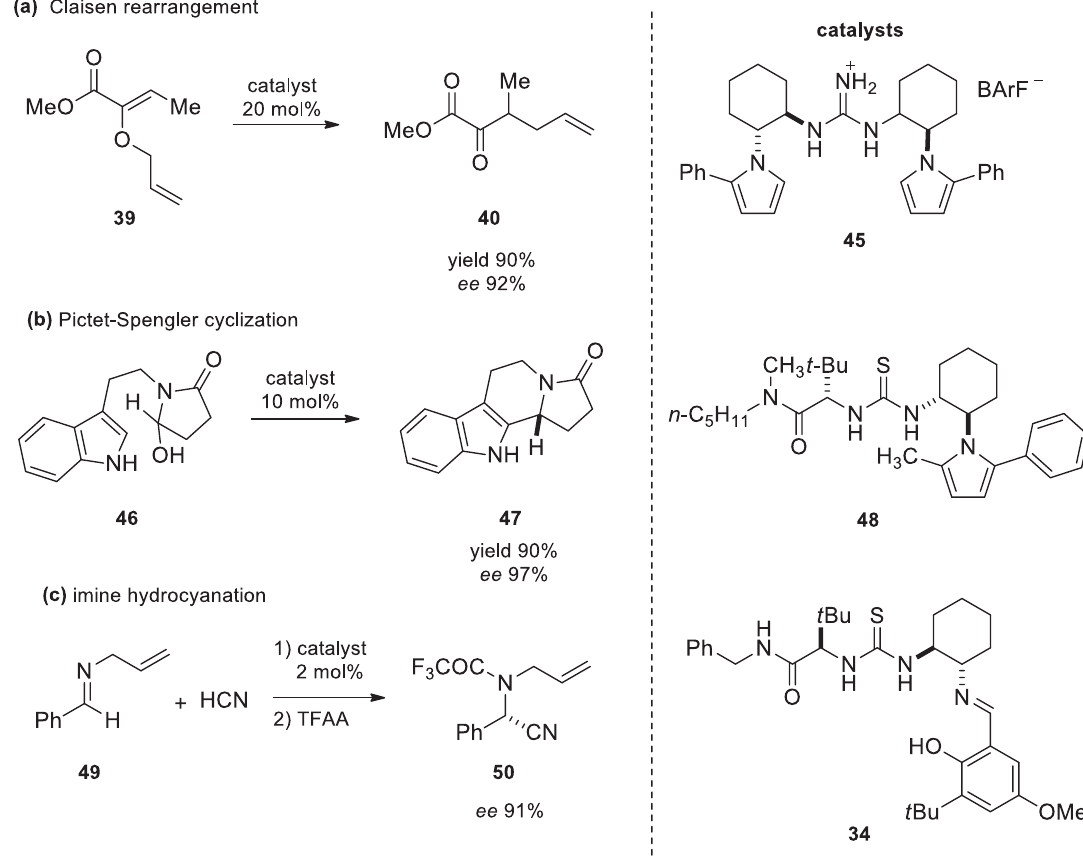
Figure 12 . Examples of reactions catalysed by H-bonding catalysts: (a) from Ref. [49], (b) from Ref. [50], (c) from Ref. [51].